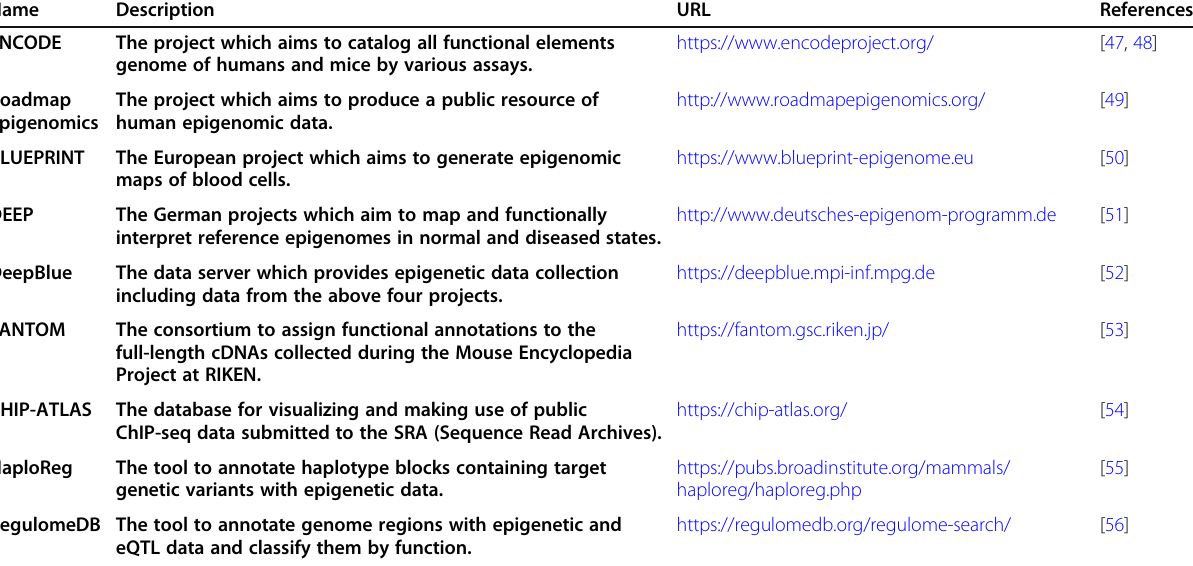
Table 2 Useful resources and tools related to epigenetic